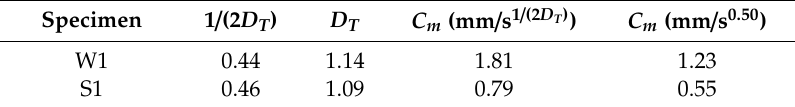
Table 6. Parameters used to predict the sorptivity of two specimens.